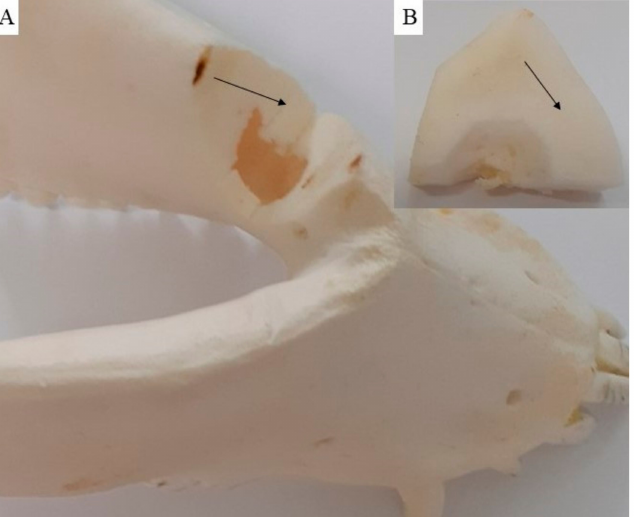
Figure 8. On the cross section ( A ), the new cortical bone ( B ) is visible, showing that the healing process resulted in uniform defect filling with new bone tissue (black